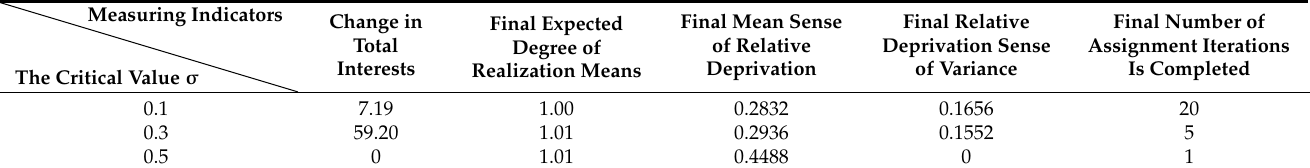
Table 8. Comparison of relevant indicators for different cut-off values.